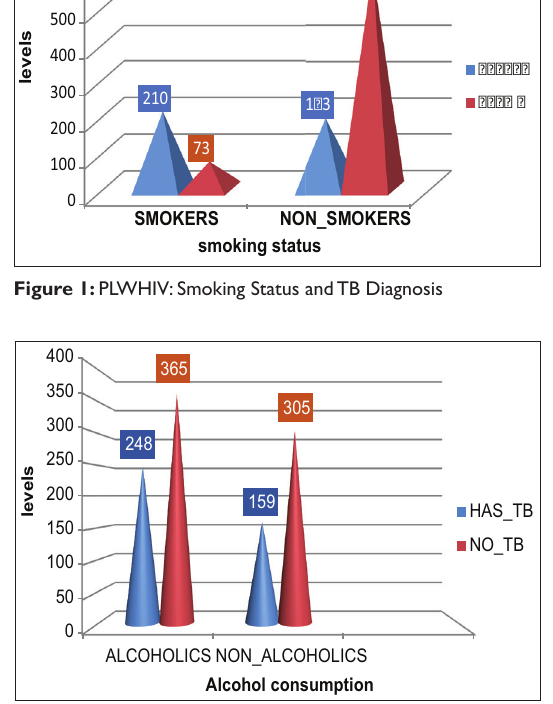
Figure 2: PLWHIV: Alcohol Use Status and TB Diagnosis The incidence of TB was associated with history of cigarette smoking, as 74.2% (210 PLHIV) of the 283 patients who smoke came up with TB compared to the 24.3% (193 PLHIV) of the 795 patients who did not smoke but developed TB, thus indicating that cigarette smokers were 3 times (that is 74.2% vs